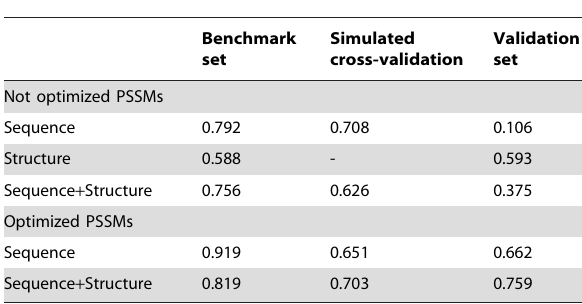
Table 2. Best Matthews correlation coefficients at high specificity ( . 90%) of the different predictors in the building and final stages of